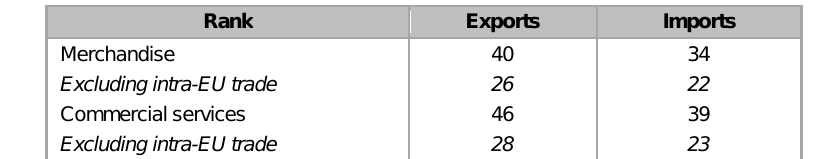
South Africa’s rank in world trade